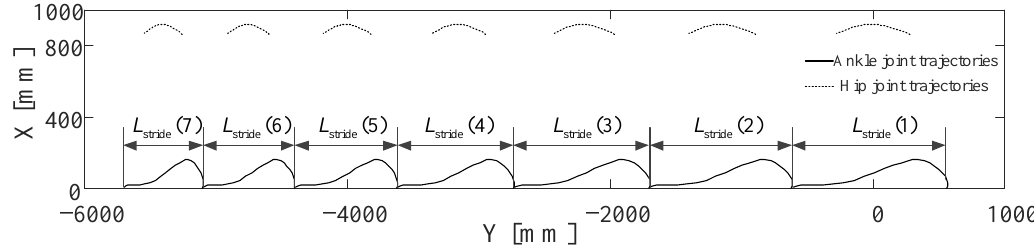
− 6000 − 4000 Figure 8. Left ankle joint and hip joint trajectories derived from planned gait with forward kinematics. Stride length can be obtained with simulation results, and the RMS error of seven left leg steps is 2.315 mm.